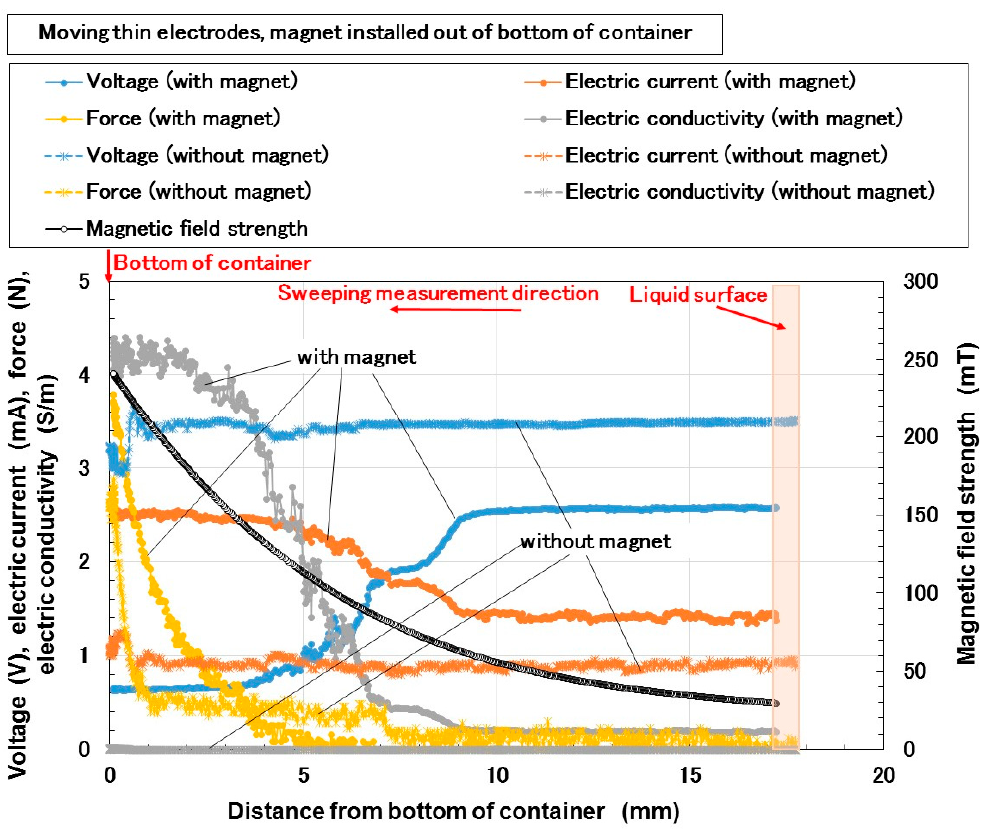
Figure 6. Changes in voltage, electric current, and electric conductivity of MCF rubber liquid, force applied, and magnetic field strength with distance from the bottom of container for moving electrodes with and without a magnet, with reference to Figure 2b,c. Magnetochemistry 2019 , 5 , x FOR PEER REVIEW